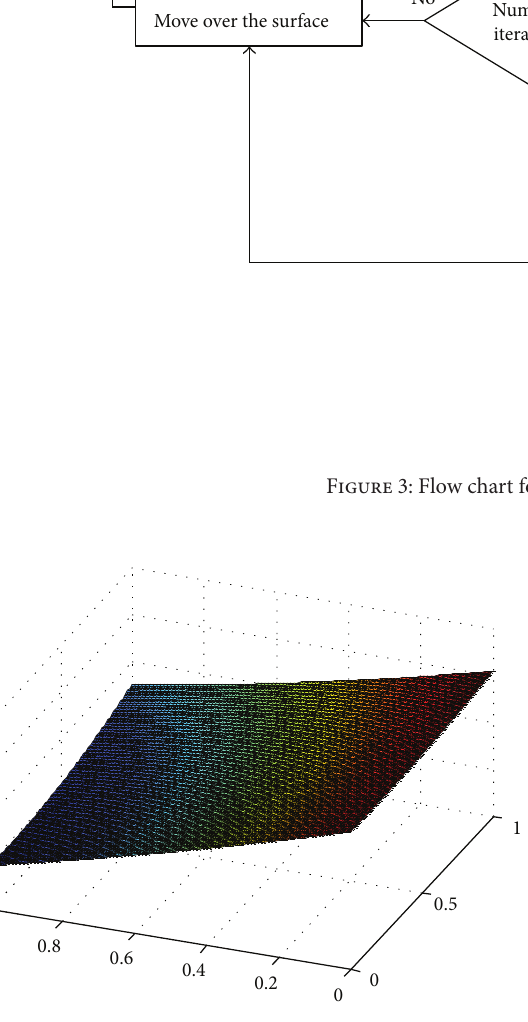
correspond to bodies such as ships, tanks or aircrafts. Most of these objects are composed of flat surfaces or convex